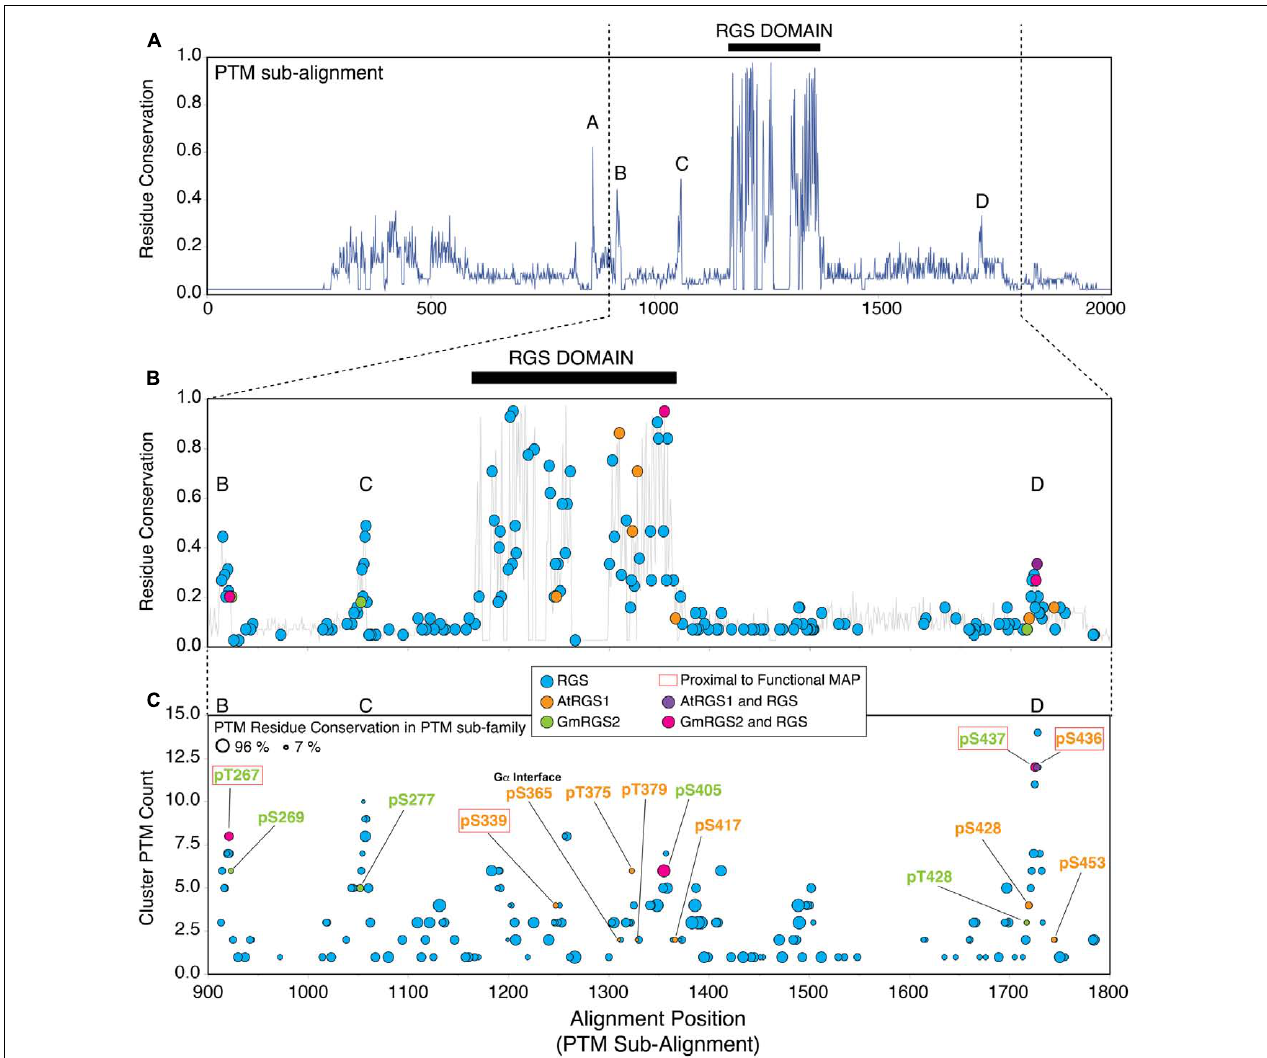
FIGURE 3 | Plant phosphosites are enriched in well-conserved phosphorylation clusters observed in non-plant RGS proteins. (A) Residue conservation (% identity) derived from MSA of AtRGS1, GmRGS2 and all non-plant RGS proteins that harbor at least one post-translational modification (PTM) (PTM sub-family). Five well-conserved regions are observed from the alignment, including: short conserved sequence regions SCR-A, SCR-B, SCR-C, SCR-D, and the RGS domain (black bar). Positions 1–2000 are shown. (B) Modified alignment positions (MAPs) for all curated PTMs in the PTM sub-family of RGS proteins. Plant MAPs are included and each MAP type is color-coded as indicated in the inset. Positions 900–1800 are shown. (C) Plant and non-plant MAPs organized by cluster PTM count (corresponds to the PTM count observed within all MAPS ± 2 alignment positions flanking the target MAP). Size of each circle indicates the percent conservation of PTM-acceptor residues within the MAP. Red boxed labels indicate that the plant MAP is proximal ( ± 2 alignment positions) to a non-plant PTM site with a characterized biological function (see text). “RGS” MAPs correspond to MAPs harboring non-plant PTMs exclusively. 7TM-RGS proteins from plants. Black bars indicate the position of the RGS